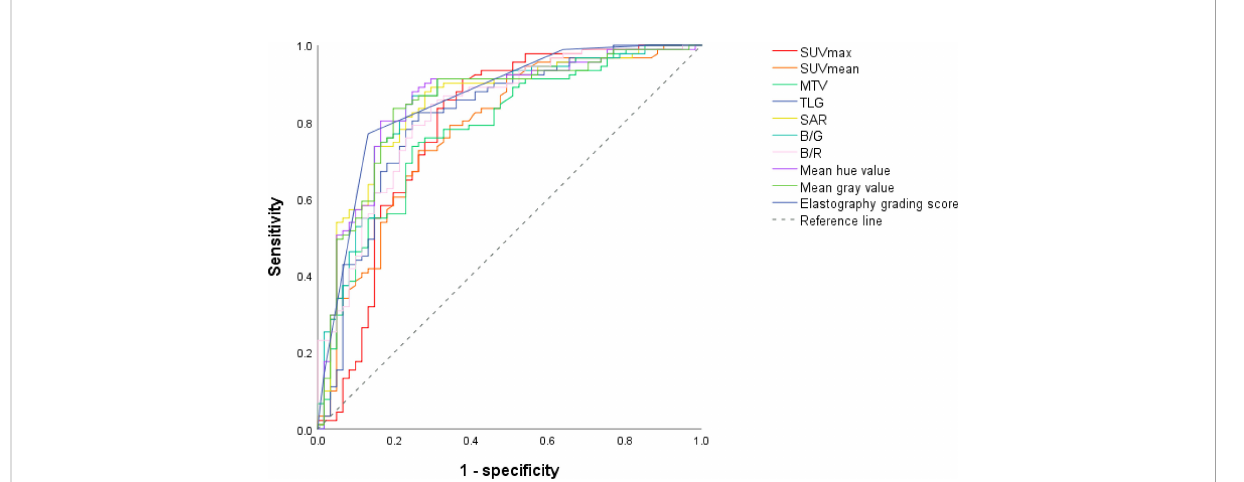
FIGURE 1 ROC curves of PET/CT and elastography parameters in the model group. Through the ROC curves, the best cutoff value re fl ecting the best diagnostic performance and the AUC value re fl ecting the overall diagnostic performance of each variable can be obtained. ROC, receiver